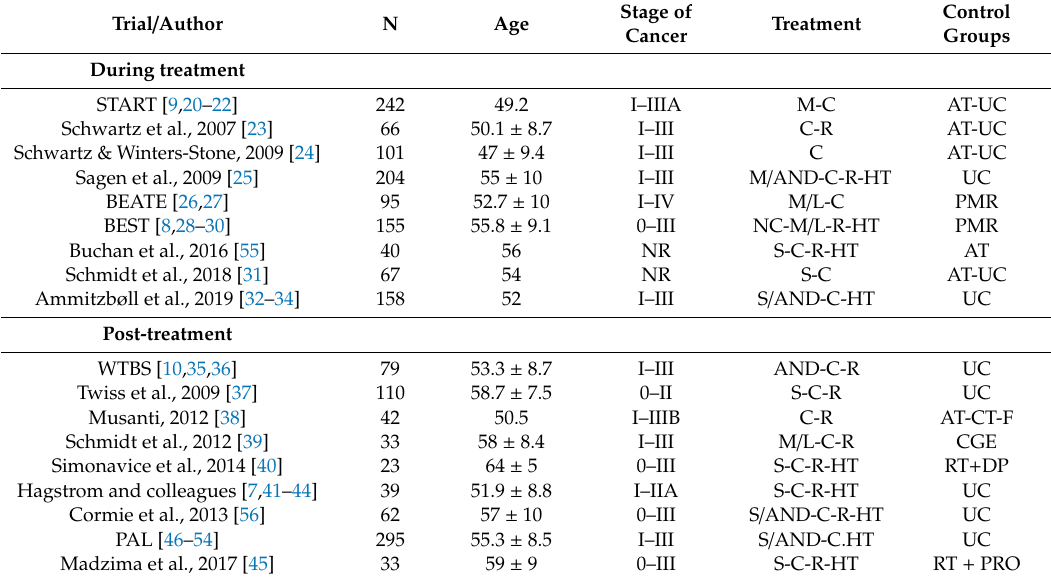
Table 6. Characteristics of controlled trials